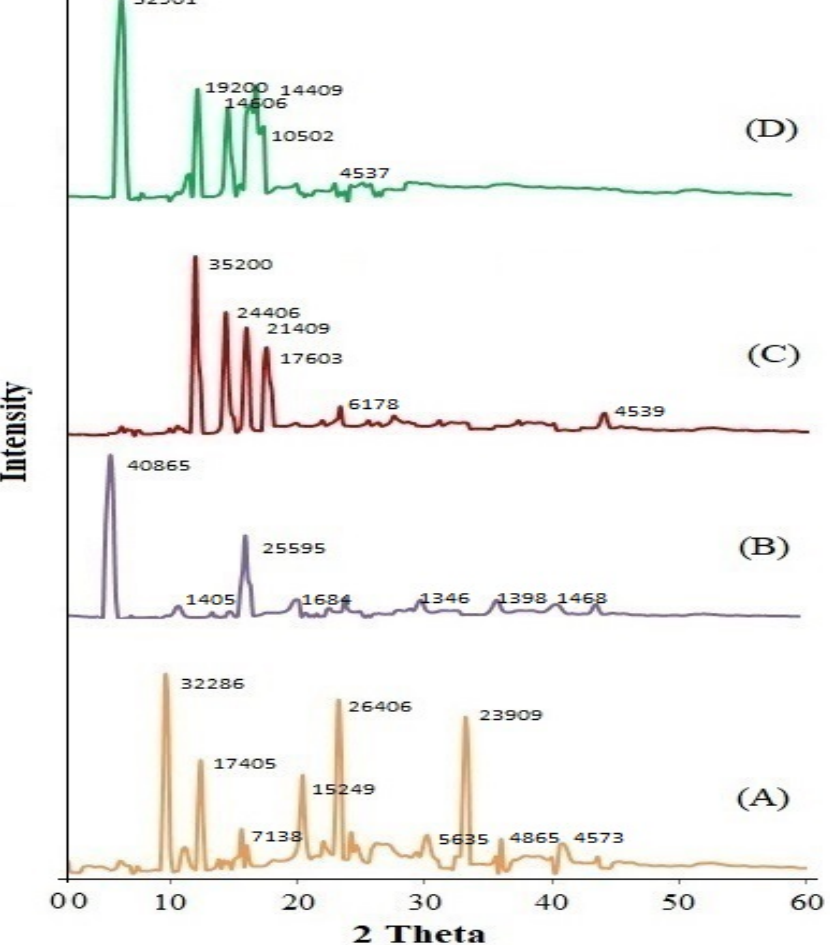
Figure 3. Showing the X-ray diffractogram of ( A ) ciprofloxacin, ( B ) cholesterol, ( C ) sodium deoxy- cholate, and ( D ) ciprofloxacin-loaded bilosomes.